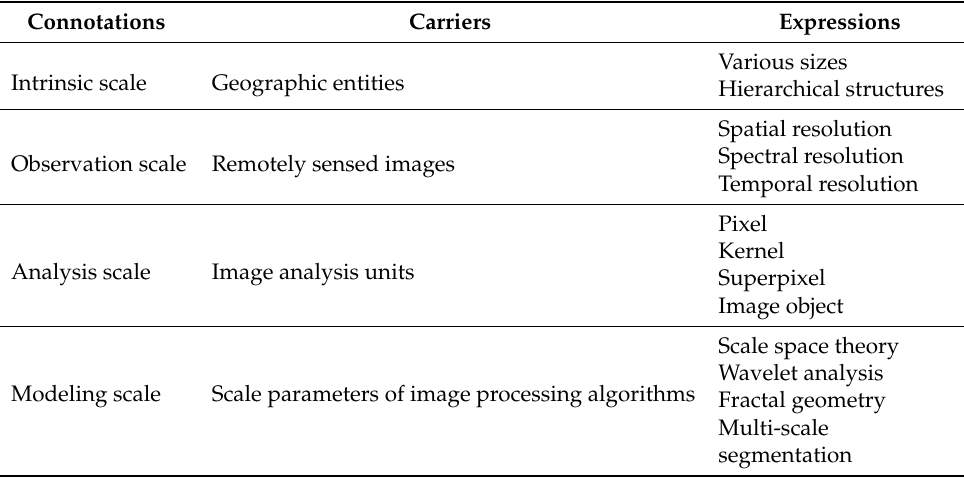
Table 1. Connotations of Scale in Remote